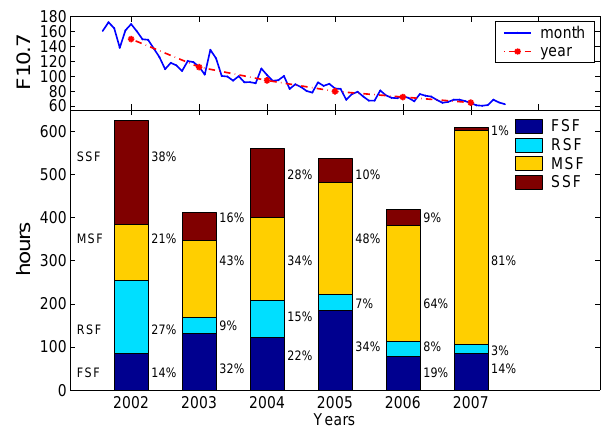
Fig. 2. Each type SF duration, total SF duration and the percentage of each type SF in total SF duration (hours) at Hainan station during the period from March 2002 to February 2008 (bottom side). The monthly and annual average of F10.7 index variations during the same period (top